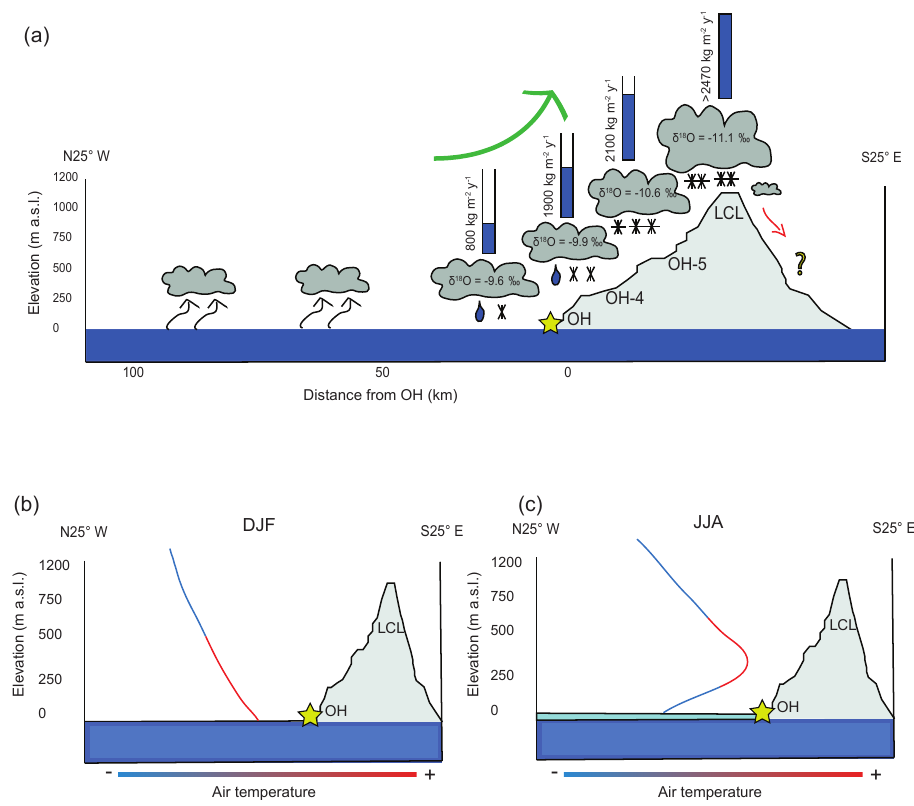
Figure 15. (a) Schematic chart showing the orographic barrier effect of the AP on the stable water isotope depletion and accumulation rate at different altitudes, firn core locations (OH-4, OH-5 and OH-6) and distances from the coast (OH); (b) temperature gradient (adiabatic cooling) during DJF (summer) and sea ice free conditions; (c) inversion layer in the lower troposhere during sea ice covered conditions in JJA (winter).